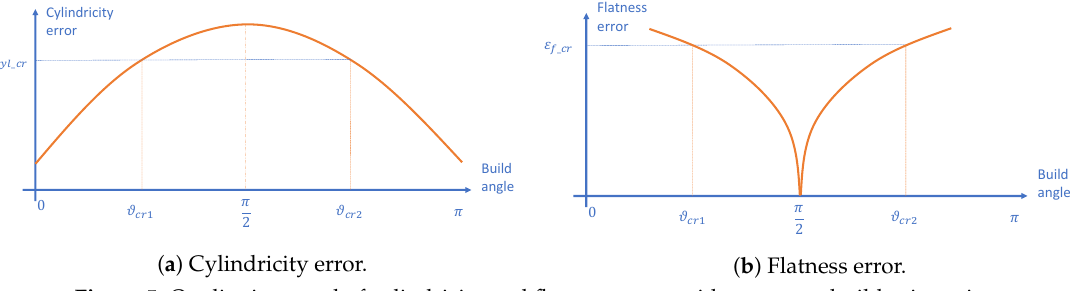
Figure 5. Qualitative trend of cylindricity and flatness errors with respect to build